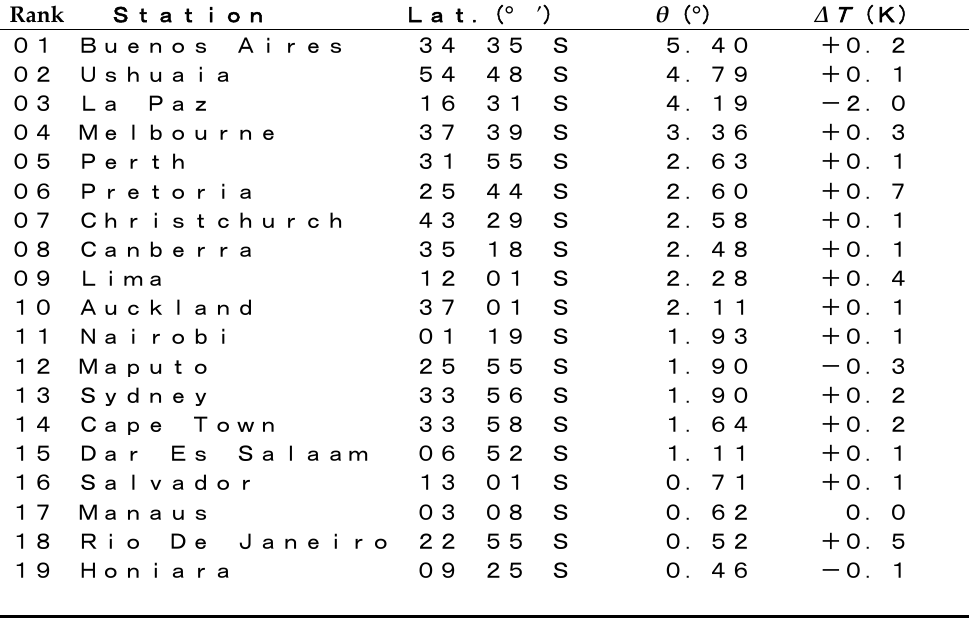
Table 3. Southern Hemispheric stations in the rotation angle of the monthly distributions of temperatures from Period I (1931 ‐ 1960) to II (1951 ‐ 1980).